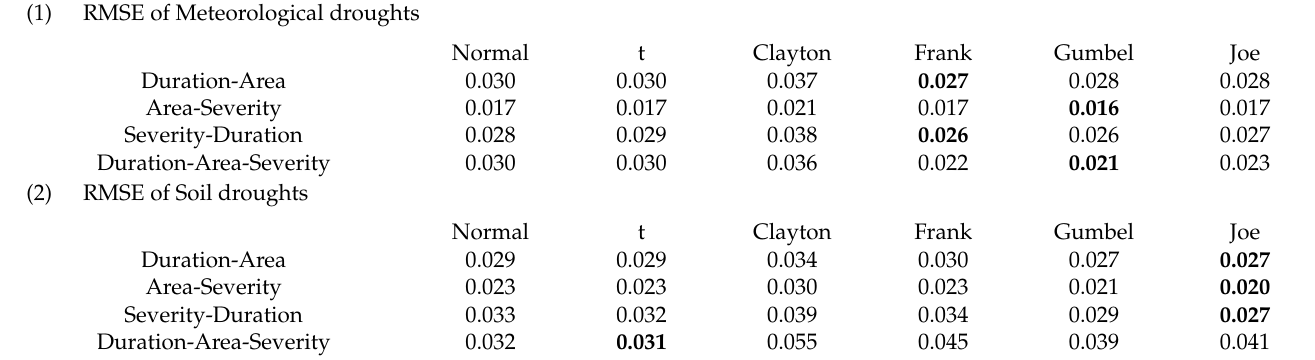
Table 2. The goodness of fits in the copulas.